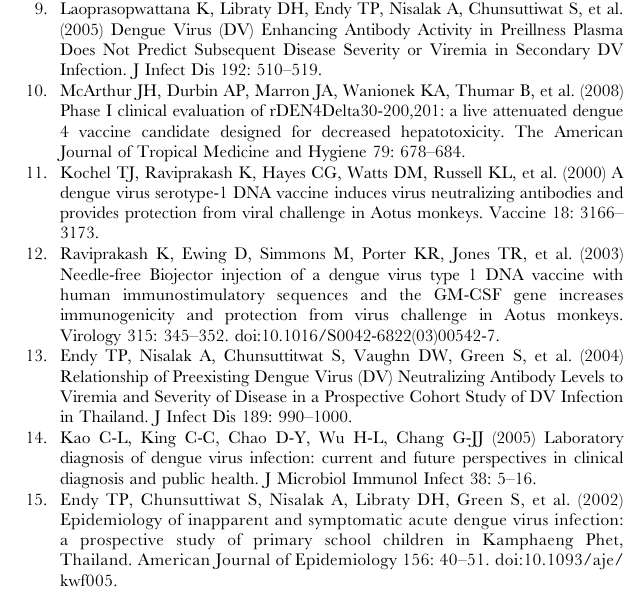
set of dilutions. (TIF) Figure S2 Width of variance 95% confidence interval with different numbers of repeated assays. Over 1,000 simulations between 2 and 30 titers were randomly sampled from all the titers (using cloglog regression at a PRNT evaluation point of PRNT 75 ) calculated from a randomly chosen viral strain – serum pool combination from a single year. The variance between the titers was then calculated. The line represents the width of the 95% confidence interval calculated from the 2.5% and 97.5% quantiles from the resultant distribution. (TIF) Figure S3 Variability in the bias in ( A ) PRNT 50 using conventional probit regression and ( B ) PRNT 75 using cloglog regression by titer (log 10 scale). The red dots represent the mean bias from each serum pool. (TIF) Text S1 Detailed methods.